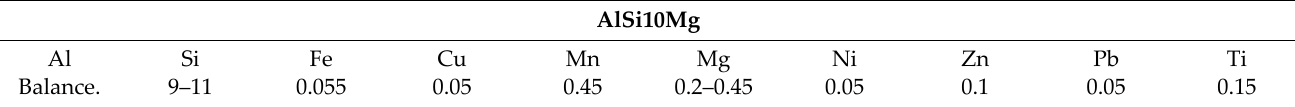
Table 1. Material composition of AlSi10Mg (wt. %).